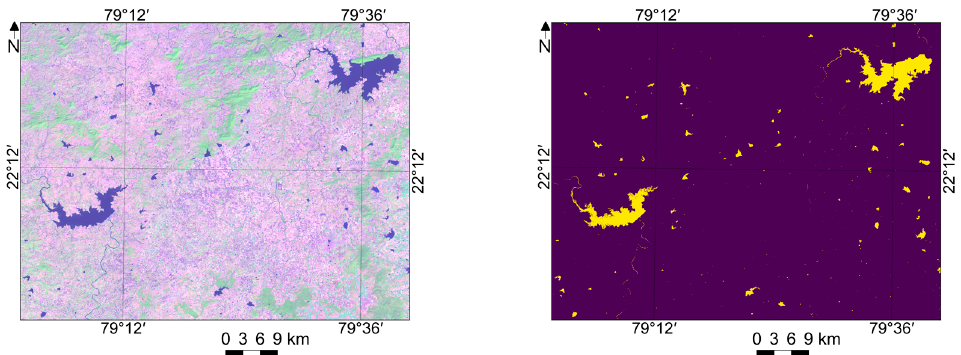
Figure B6. Water/non-water region estimation using Landsat-8 image collected on 2014-04-16.